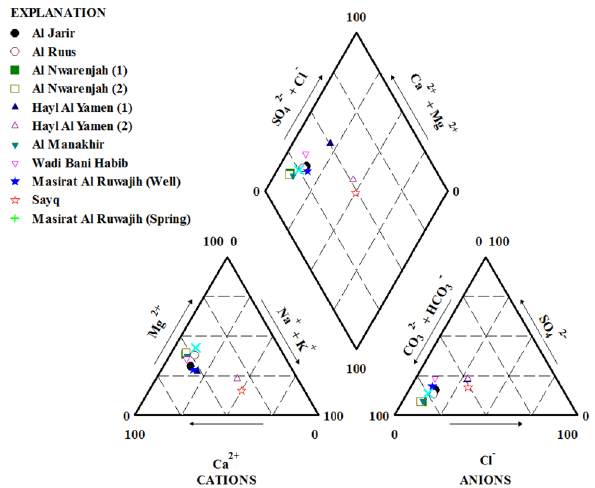
Fig. 5 Piper’s trilinear diagram of groundwater resources of the study area sampled during summer 2012–2013